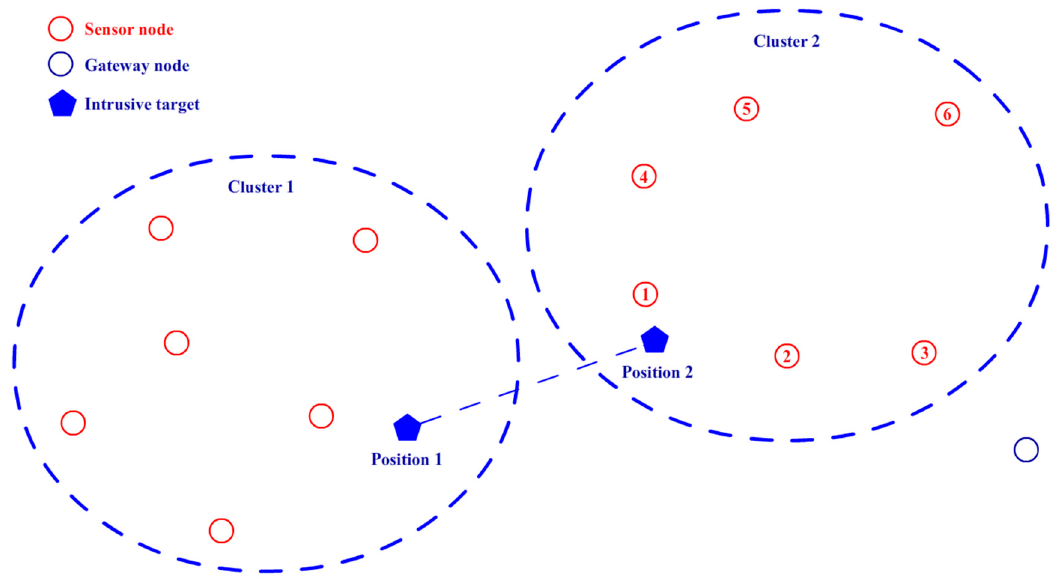
Figure 7. Example of the data fusion procedure.